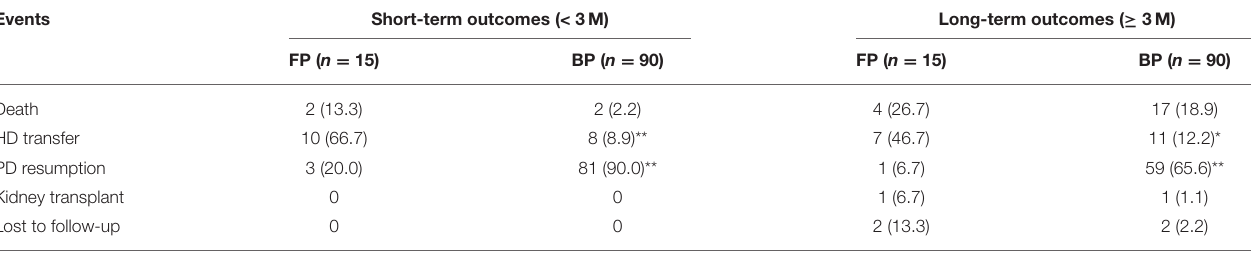
TABLE 4 | Clinical outcomes of patients with FP and BP [ n (%)].